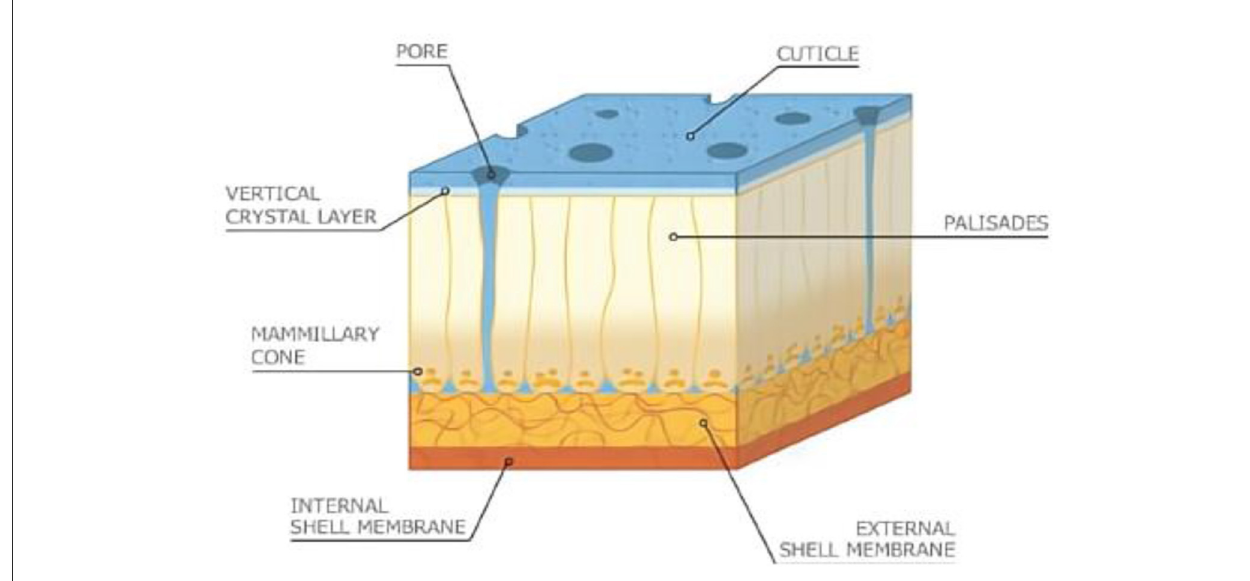
FIGURE1 Artistic rendition of cross-sectional view of eggshell. Image reproduced from Hincke et al.